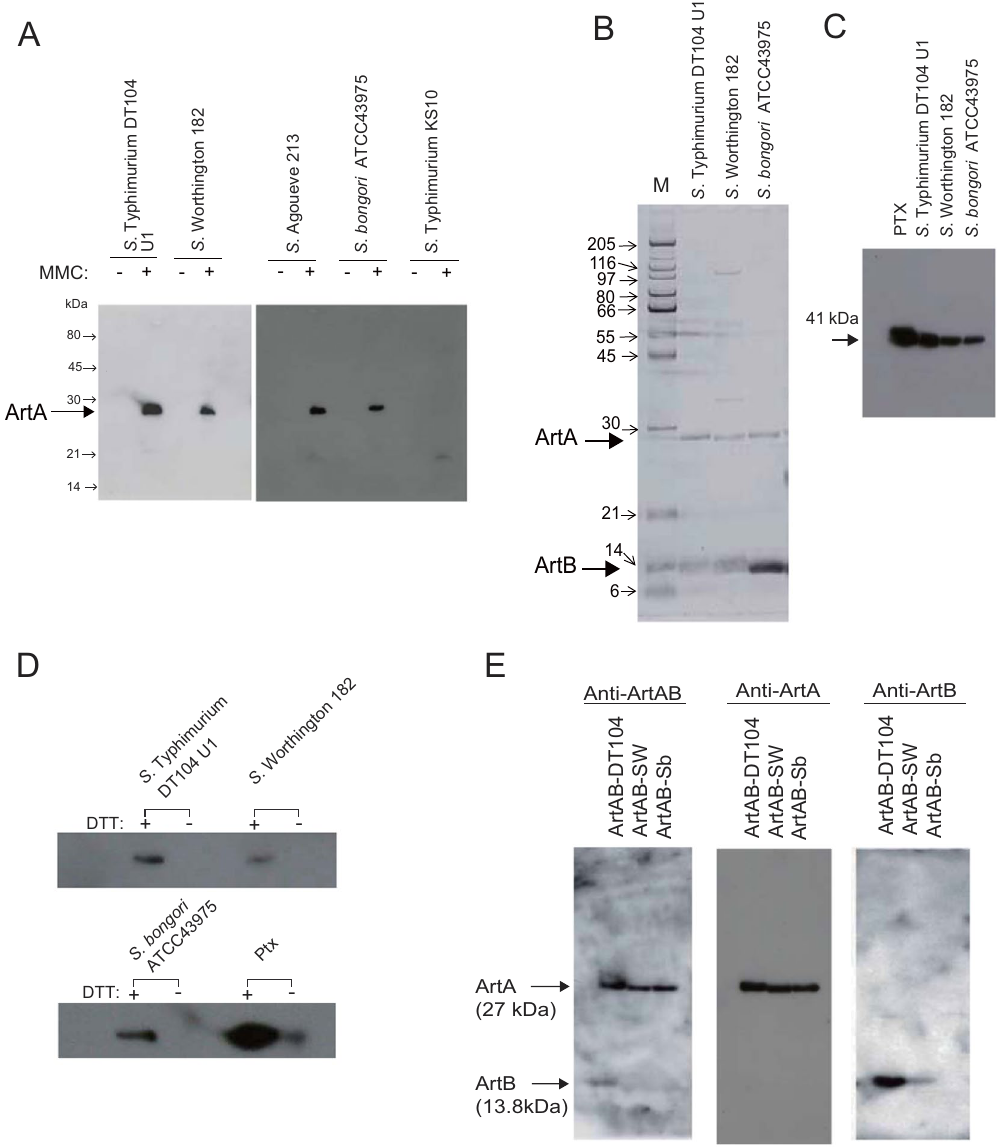
Figure 1. Expression and purification of ArtABs. ( A ) Induction of ArtA expression in Salmonella strains by treatment with mitomycin C (MMC). Overnight cultures grown in syncase broth with ( + ) or without ( − ) 0.5 μ g/ml MMC were centrifuged to separate the cells. The supernatant was passed through a 0.22- μ m filter, and concentrated 15-fold using a Vivaspin 10 K (GE Healthcare). Total protein contents from the supernatants of S . Typhimurium DT104 strain U1, S . Worthington strain 182, S . Agoueve strain 213, S . bongori strain ATCC43975, and S . Typhimurium strain KST10 were resolved by SDS-PAGE and probed with an antibody against the 14-a.a. peptide corresponding to the Arg 10 –His 23 sequence of S . Typhimurium DT104 ArtA. ( B ) SDS-PAGE analysis of purified ArtABs from Salmonella strains. Purified ArtAB from S . Typhimurium DT104 stain U1, S . Worthington strain 182, and S . bongori ATCC43975. The gel was stained using a silver staining kit. ( C , D ) ADP-ribosylation of Ptx-sensitive G proteins by ArtABs; Ptx-sensitive G proteins from bovine brain (0.1 μ g) were incubated with biotinylated NAD and purified ArtABs (100 ng) isolated from the indicated strain for 1 h at 37 °C, and then ADP-ribosylated proteins were analysed by 12.5% SDS-PAGE ( C ), and ADP-ribosylation in the presence or absence of 20 mM DTT ( D ). ( E ) Western blot analysis of purified ArtABs. ArtAB-DT104, ArtAB-SW, and ArtAB-Sb were probed with rabbit anti-ArtAB, anti-ArtA, and anti-ArtB